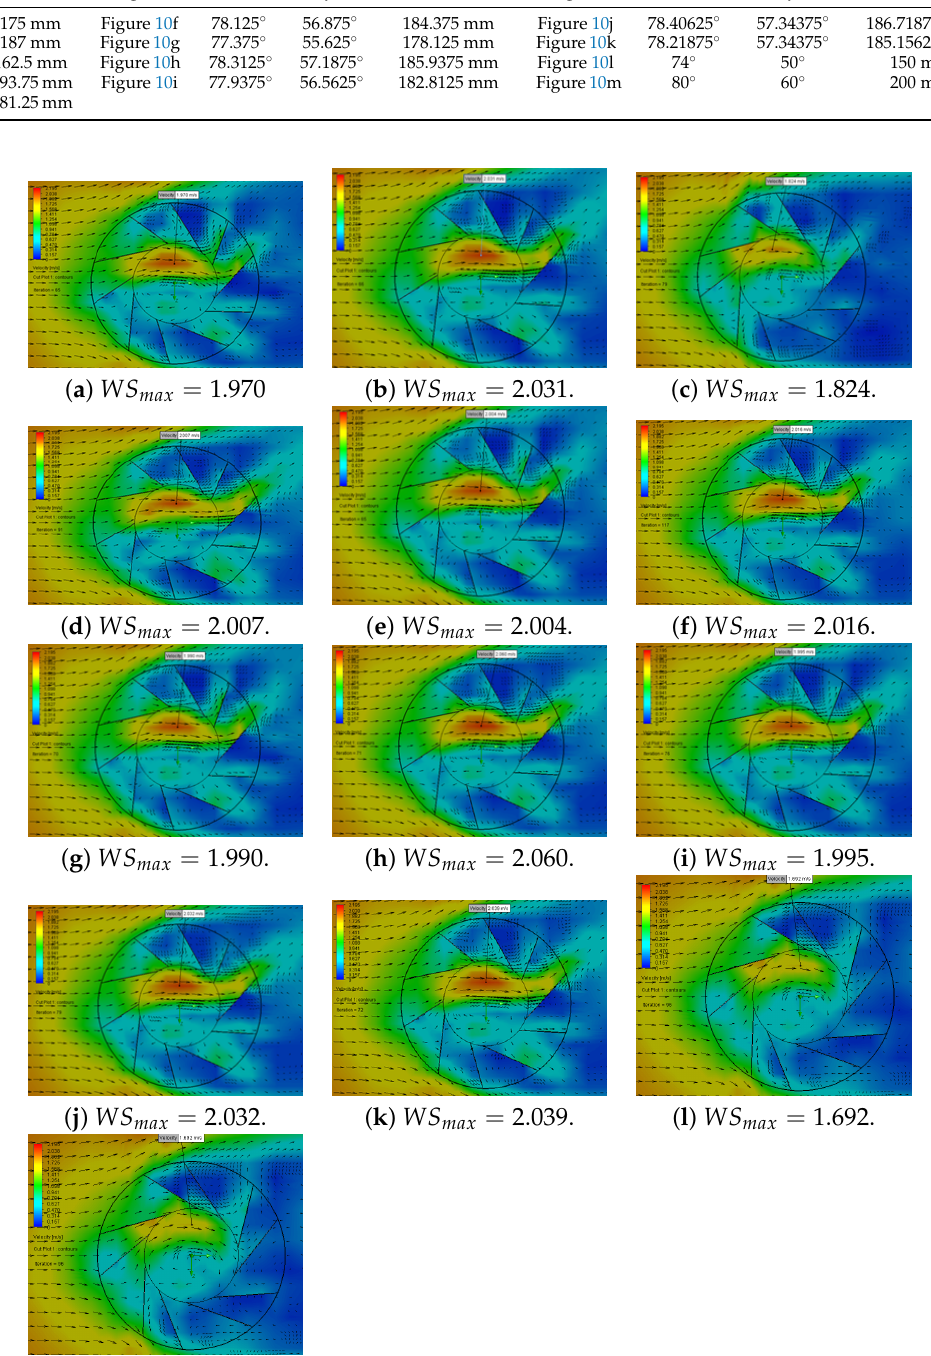
Figure 10. Results of flow simulations under bisection DOE. Figure 11 presents how the Wind Booster configuration changes using the bisection algorithm to obtain the maximum wind velocity inside the ODGV. The red line indicates the best result, which corresponds to a value of θ = 78.3125 ◦ , β = 57.1875 ◦ and distance between the blades D bb = 185.9397